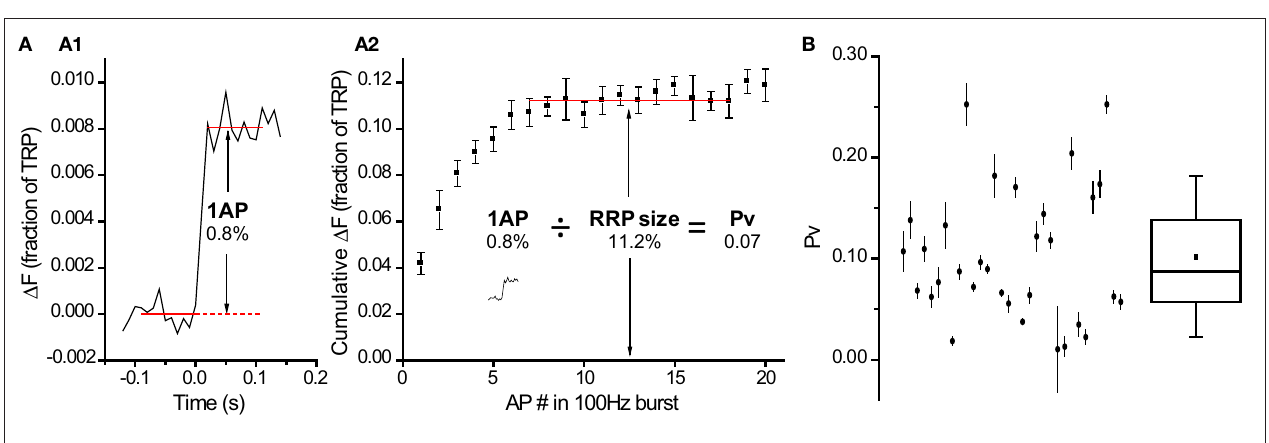
Figure 5 | Pv varies over a wide range across cells. (A) Procedure for determining a neuron’s Pv requires a measurement of the response to 1 AP ( A1 , n = 20 trial average, 12 synapses) and an estimate of the RRP size ( A2 , n = 4 trial average). Values within each panel are in % of TRP. The trace from (A1) was